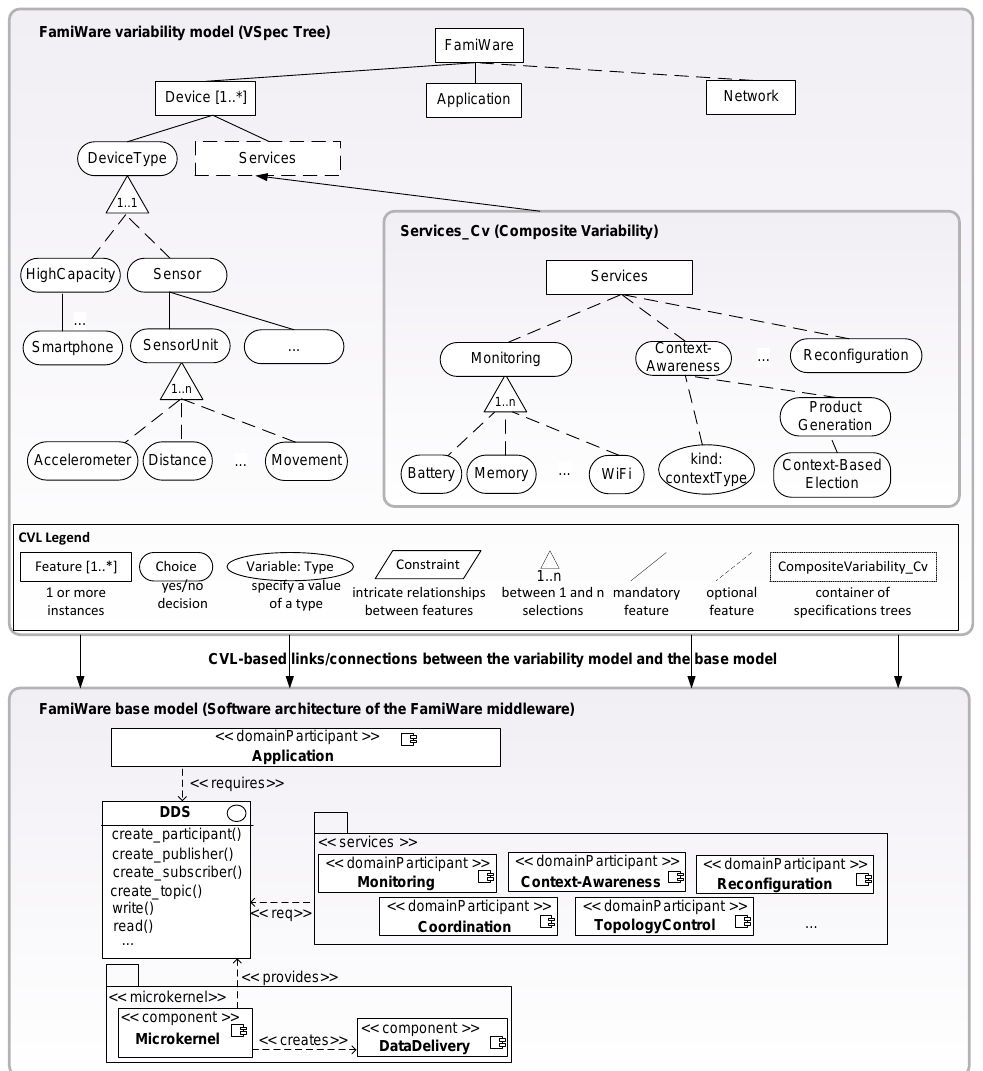
Figure 1. FamiWare variability